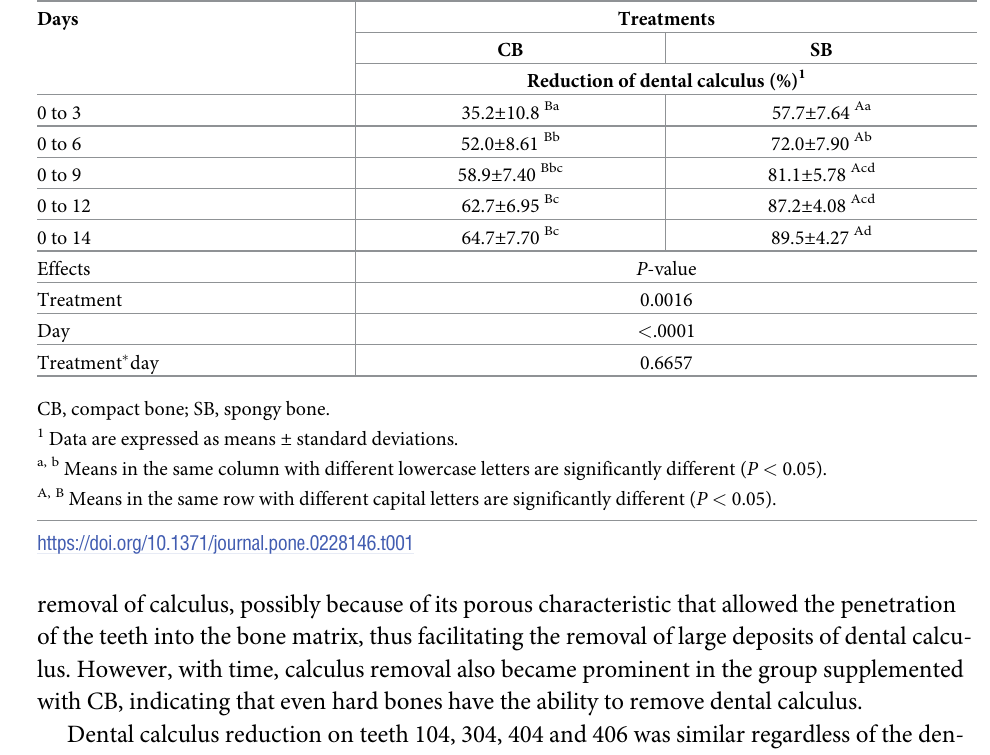
Table 1. Dental calculus reduction (%) in adult Beagle dogs receiving two different types of beef bones. Days